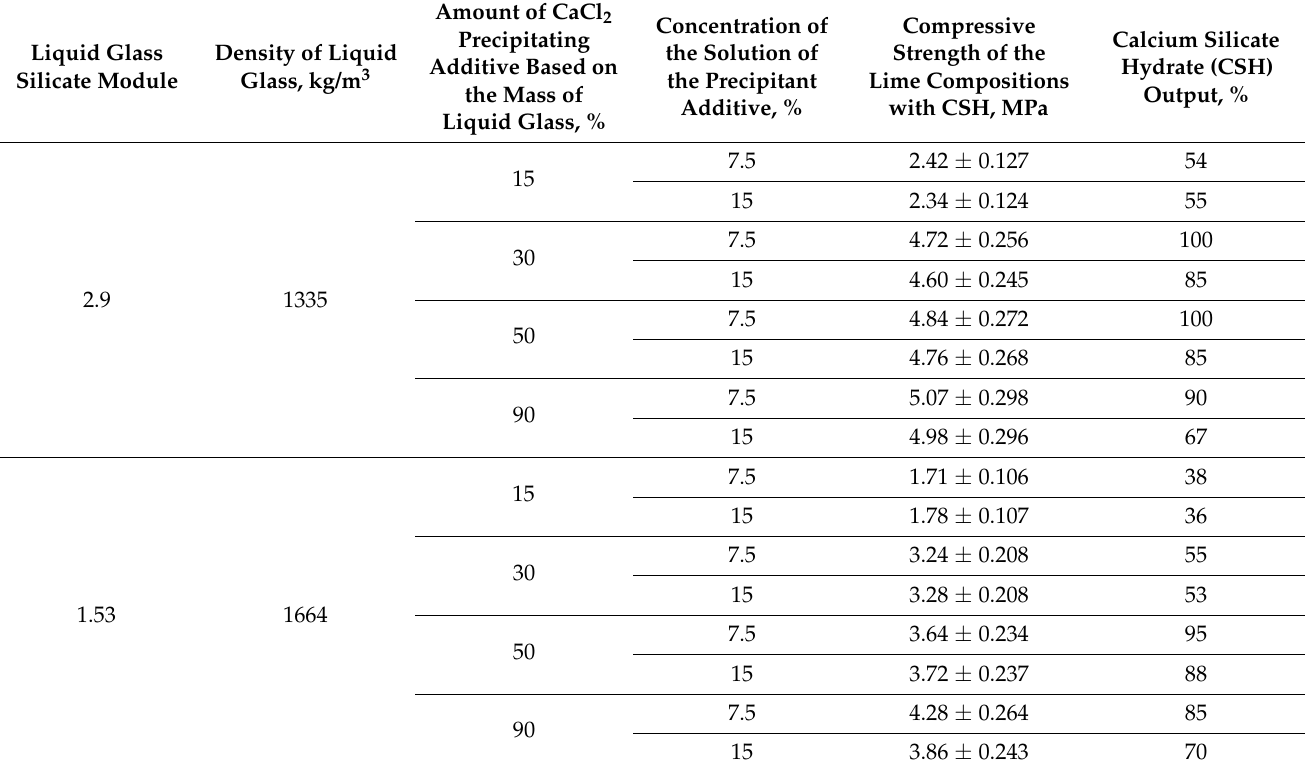
Table 3. Compressive strength of the modified lime composites (specimens 03A).